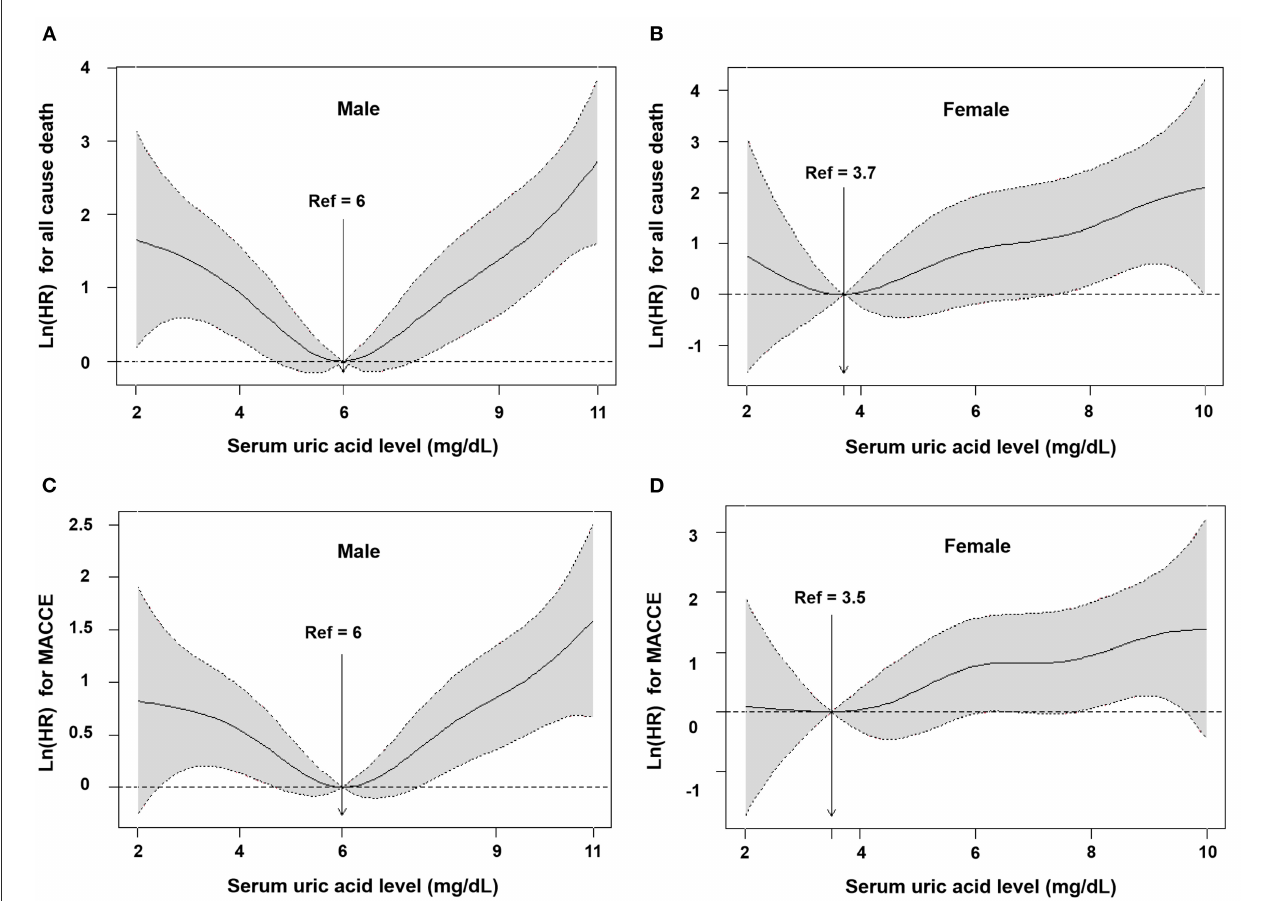
FIGURE1 Cubic spline models for association between serum uric acid and outcomes according to sex. All cause death among male (A) and female (B) , and MACCE among male (C) and female (D) . Hazard ratio (solid line) from restricted cubic spline modes for all-cause death and MACCE using baseline uric acid levels. Shading represents 95% confidence intervals. HR, hazard ratio; MACCE, major adverse cardiovascular and cerebrovascular